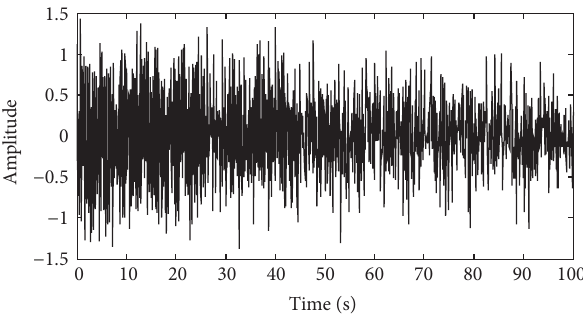
Figure 5: Displacement response with noise of case